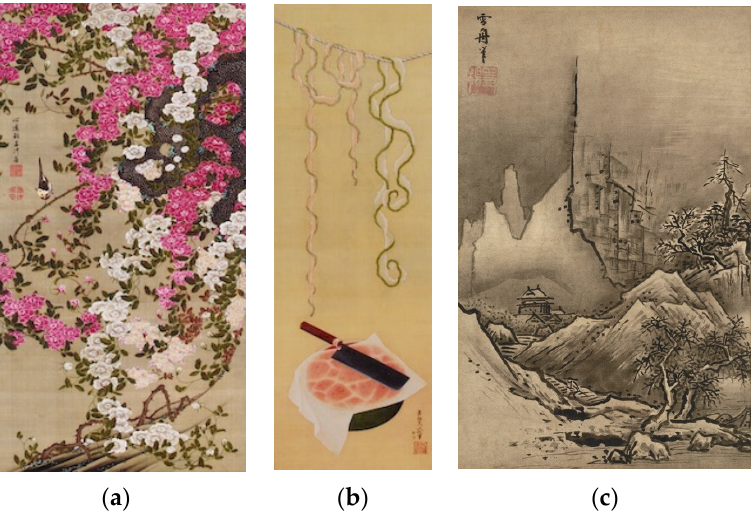
Figure 3. ( a ) ITO Jakuch ū , “ Bara Sh ō kin-zu” (Roses and Small Bird), one of the painting “ D ō shoku Sai-e” , hanging scroll, color on silk, 142.6 × 79.7 cm, 1761-1765, The Museum of the Imperial Collections, Sannomaru Shozokan, Tokyo, Japan; ( b ) KATSUSHIKA Hokusai, “ Watermelon” , hanging scroll, color on silk, 86.1 × 29.9 cm, 1839, The Museum of the Imperial Collections, Sannomaru Shozokan, Tokyo, Japan; ( c ) SESSH Ū T ō y ō , “ Landscapes of Autumn and Winter” , hanging scroll, ink on paper, 46.3 × 29.3 cm, 15~16c, Tokyo National Museum, Tokyo, Japan.